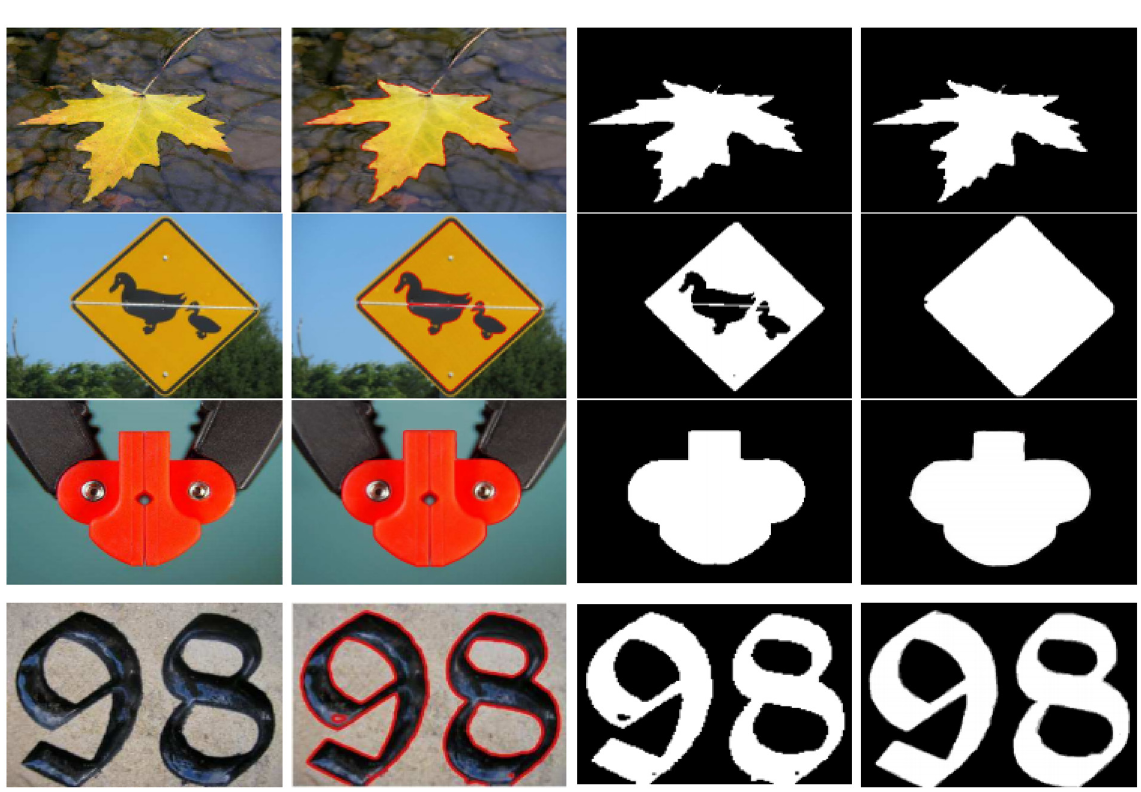
Fig 15. The segmentation and saliency cut results generated through the proposed model. The results are arranged as: given image, segmented results, saliency cut results, and the GT. The results are similar but not identical to the original images and is therefore for illustrative purposes